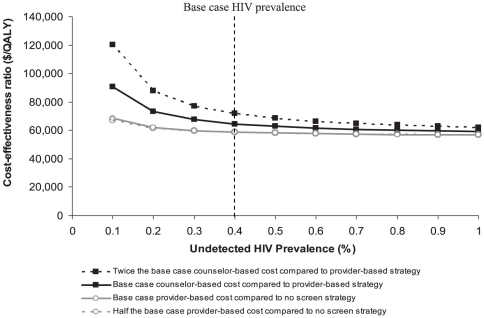
Sensitivity of incremental cost-effectiveness ratio (vertical axis) to alternative undetected HIV prevalences (horizontal axis).The incremental cost-effectiveness of the Provider strategy, compared to No Screen, is shown by the open circles. The incremental cost-effectiveness of the Counselor strategy, compared to the Provider strategy is provided by the closed squares. The dashed line (open circles) is the incremental cost-effectiveness of the Provider strategy, compared to No Screen, at half the base case provider-based screening costs ($4.05/result received). The dashed line (solid squares) is the incremental cost-effectiveness of Counselor strategy, compared to the Provider strategy, at twice the base case counselor-based screening costs ($62.00/result received).